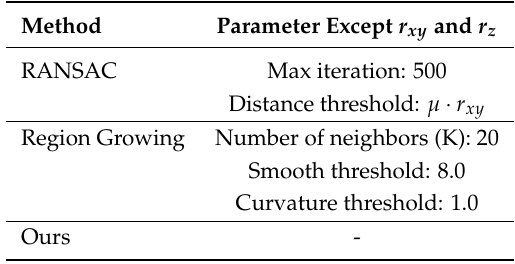
Table 1. Parameter Used for Evaluations on TUM Dataset.